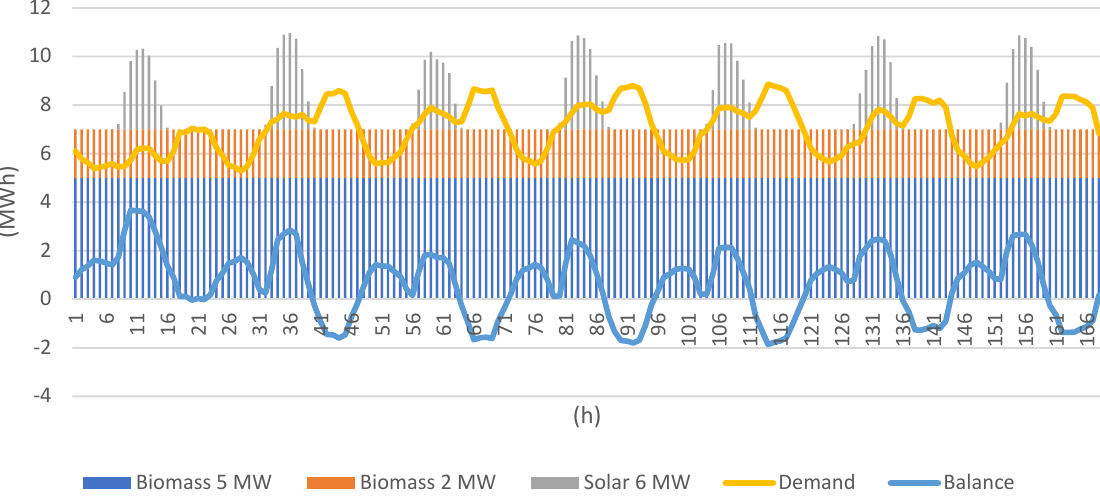
Figure 13. Energy balance sample.